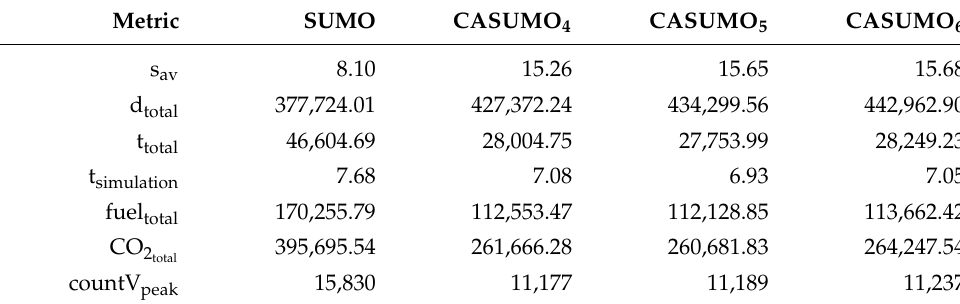
Table 4. Results for 50 K+ simulated vehicles in New